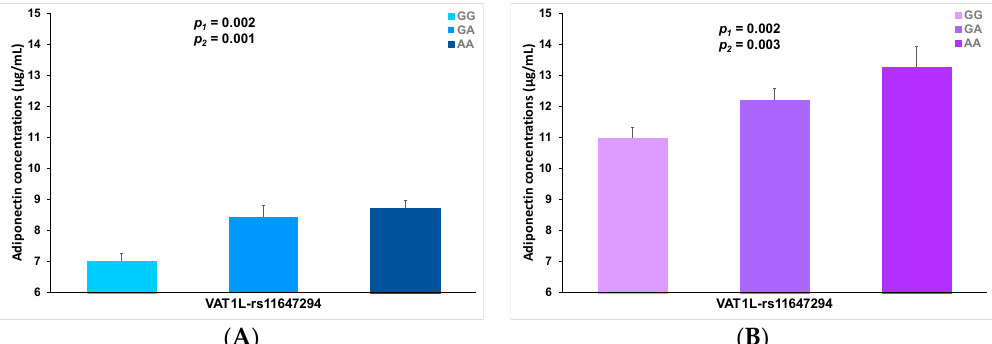
Figure 3. Regional plot for the SNP rs11647294, located in the vesicle amine transport 1 like ( VAT1L ) gene, on chromosome 11 in the GWAS, for adiponectin concentrations in the whole population. p - values obtained in the general linear regression model adjusted for sex, age, diabetes and BMI.